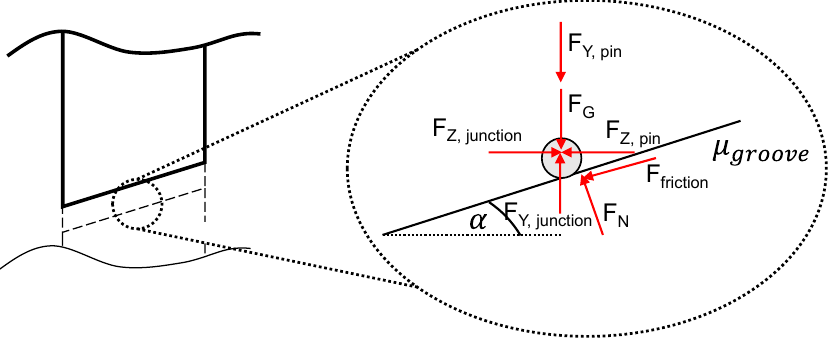
Figure 11. Contact surface of the junction pin and the inclined plane of the circumferential groove.